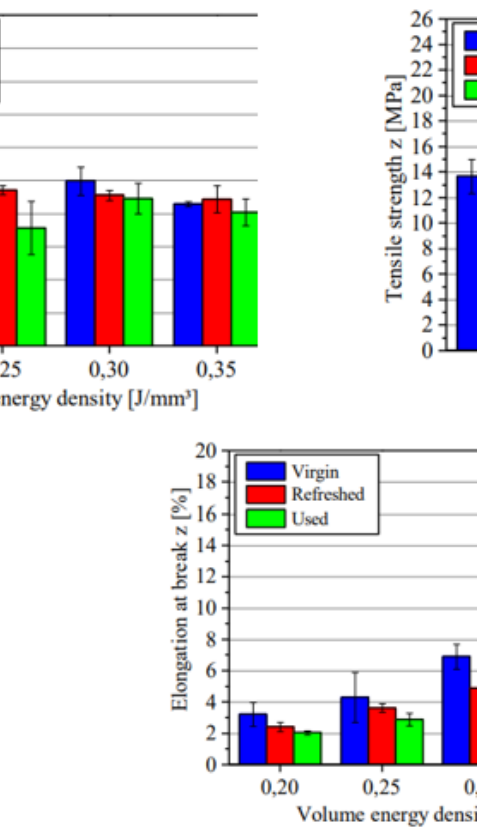
Table 13. Dimensional errors of L ‐ PBF printed parts. Measurement